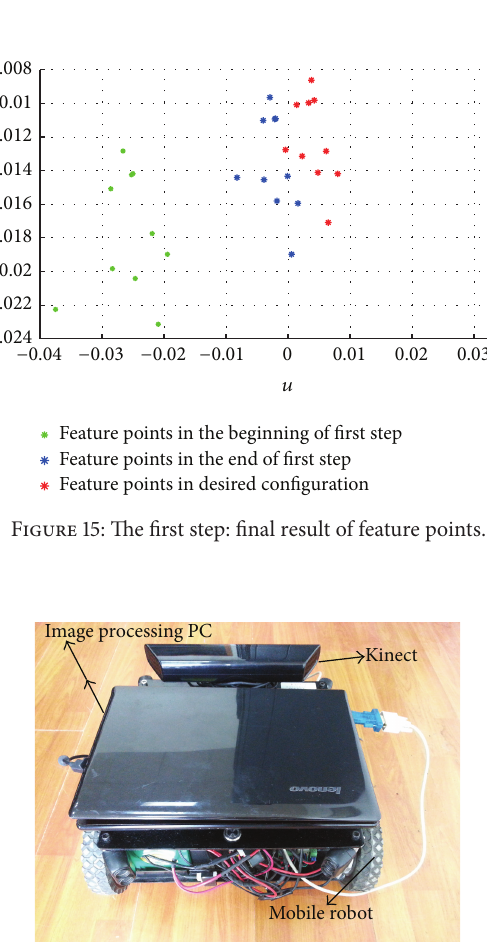
Figure16:Testbed.Mobilerobotusedfortheexperimentsequipped with a KINECT by Microsoft Company, Ltd.